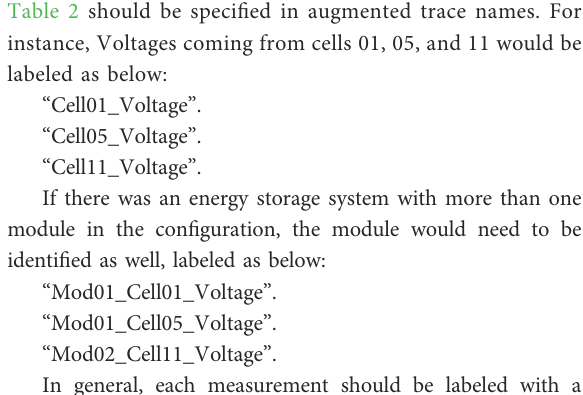
Table 2 should be speci fi ed in augmented trace names.